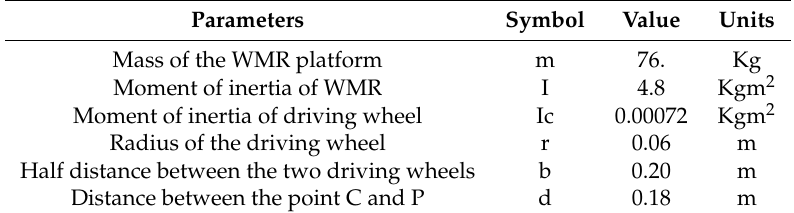
Table 1. Parameters of WMR used for simulation.